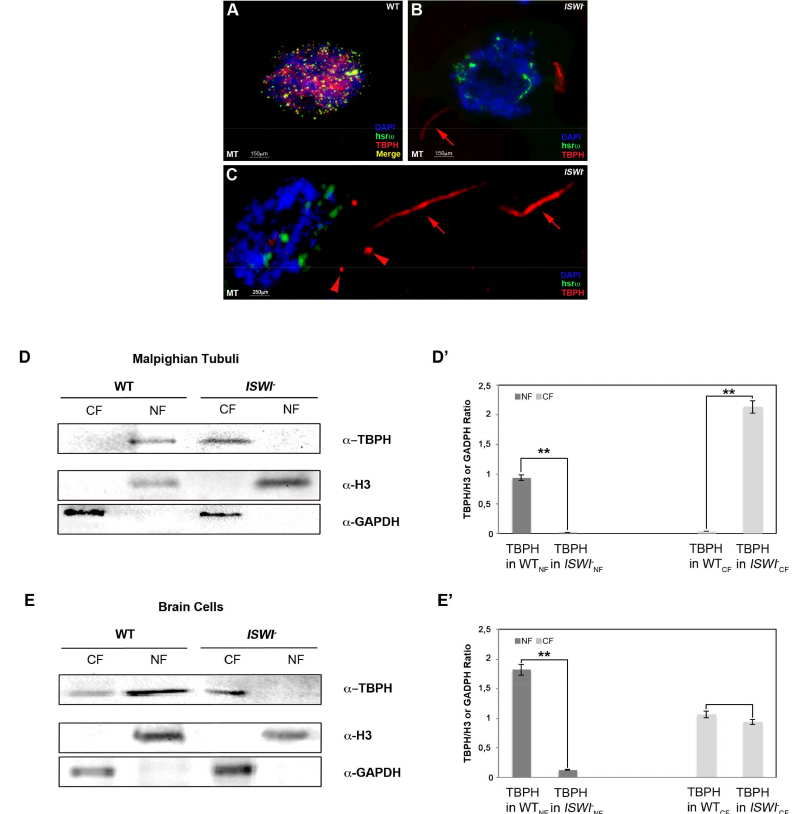
Figure 4. Loss of ISWI causes severe changes in TBPH localization. ( A – C ) Compared to WT ( A ), loss of ISWI dramatically changes TBPH protein (red) distribution between the nucleus and cytoplasm in MT of ISWI - null mutants ( B ), and higher magnification of other cells in ( C ). TBPH loses its co-localization with hsr ω (green) and it is predominantly distributed in the cytoplasm (red arrows). Moreover, TBPH in the cytoplasm seems to be organized in different trail-like structure (arrows) or dot (arrowheads) ( C ), ( D , E ) Cellular fractionation experiments analyzed by Western blots confirming the data for MT cells ( D ), as well as BCs ( E ). Anti-GAPDH and anti-H3 were used as internal control to normalize CF and NF. ( D’ , E’ ) The intensity of Western blot signals was quantified using ImageJ. The experiment was performed considering five biological replicates. The error bars show the standard deviation. Unpaired Student’s t -test was performed to assay statistical significance; * 0.01 ≤ p -value ≤ 0.05; ** p -value <